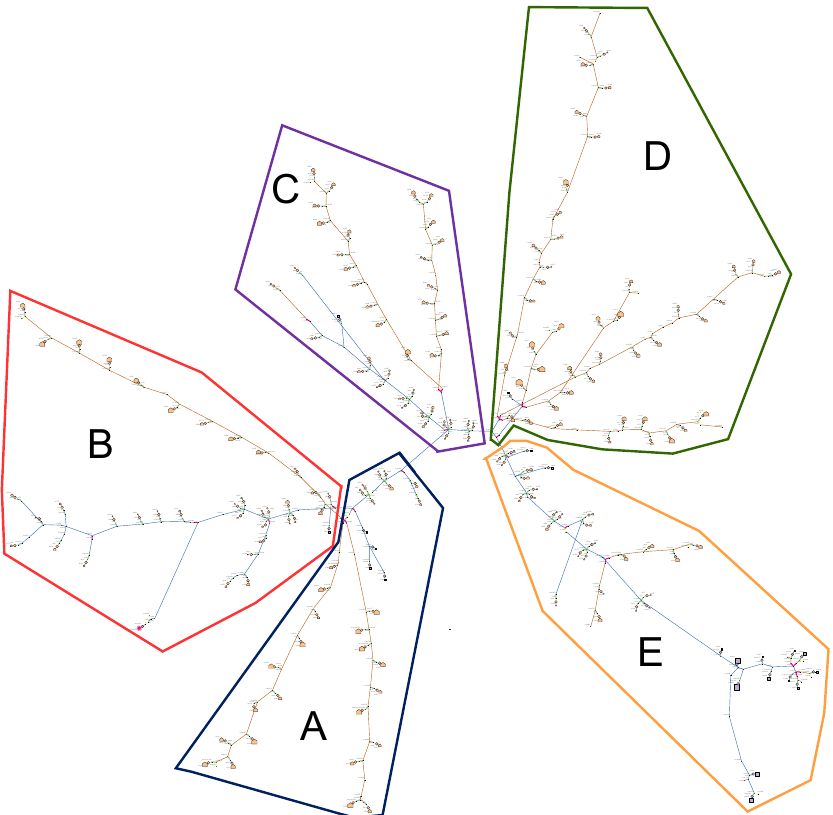
Figure 3. R4-12.47-2—A PNNL taxonomy feeder [32], where A, B, C, D, and E, are the correspond- ing